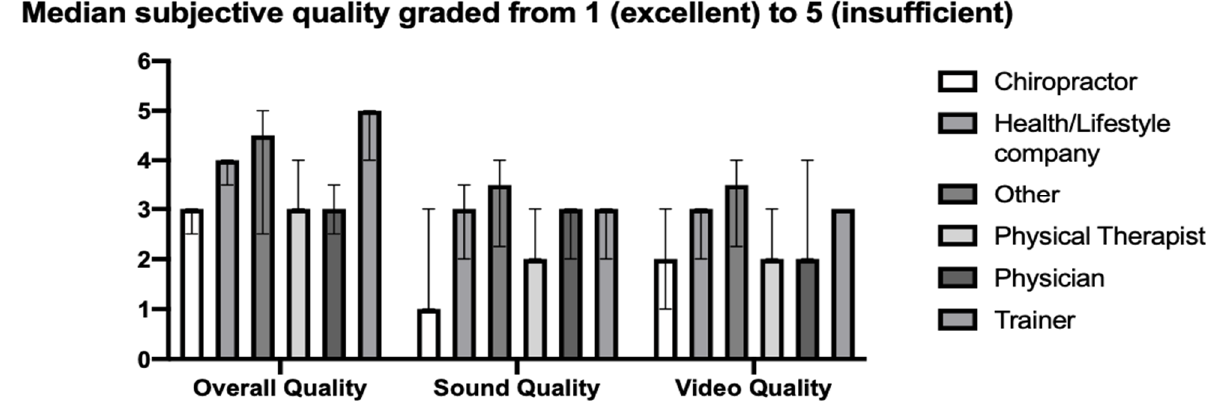
Figure 2. Median subjective grade for overall, video and sound quality displayed by video source including the upper and lower quartile. While no significant difference in means could be observed among video sources regarding their sound and video quality, a better overall grade was assigned to physiotherapist and chiropractor videos when compared to trainer videos.